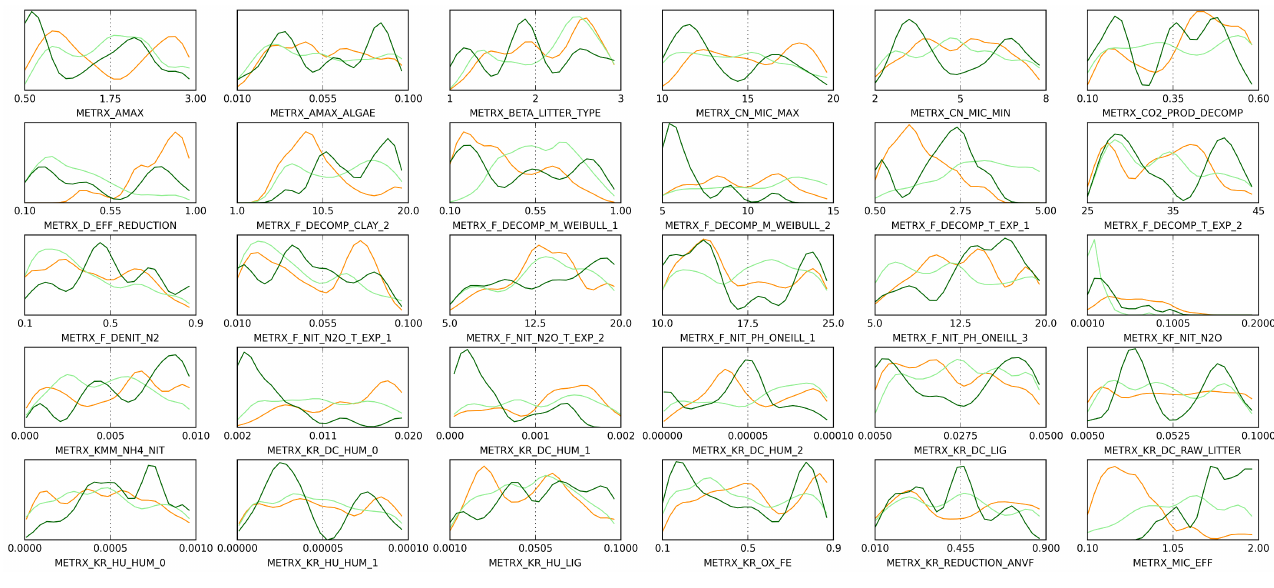
Figure A5. Posterior parameter distribution of the LandscapeD- NDC module MeTrx. Orange line, arable land; light green line, grassland; dark green line, forest model set-up.